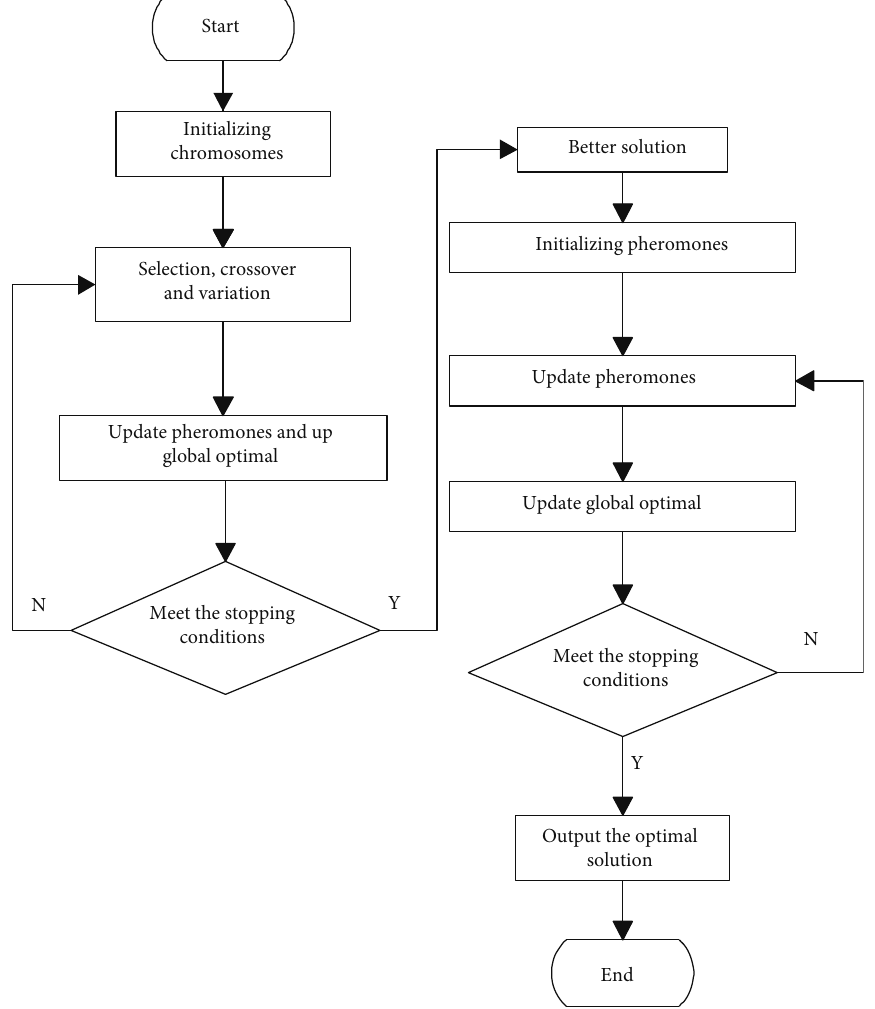
Figure 3: The fl ow chart of the AGA